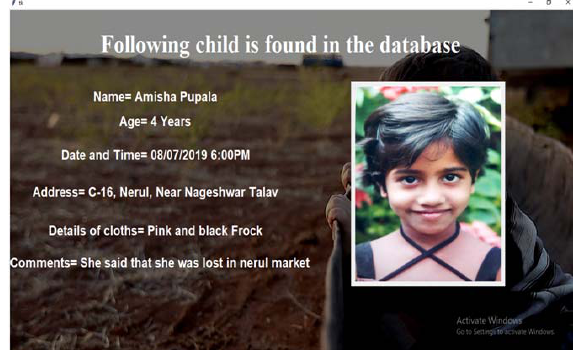
Figure 10. Details of the child found in the